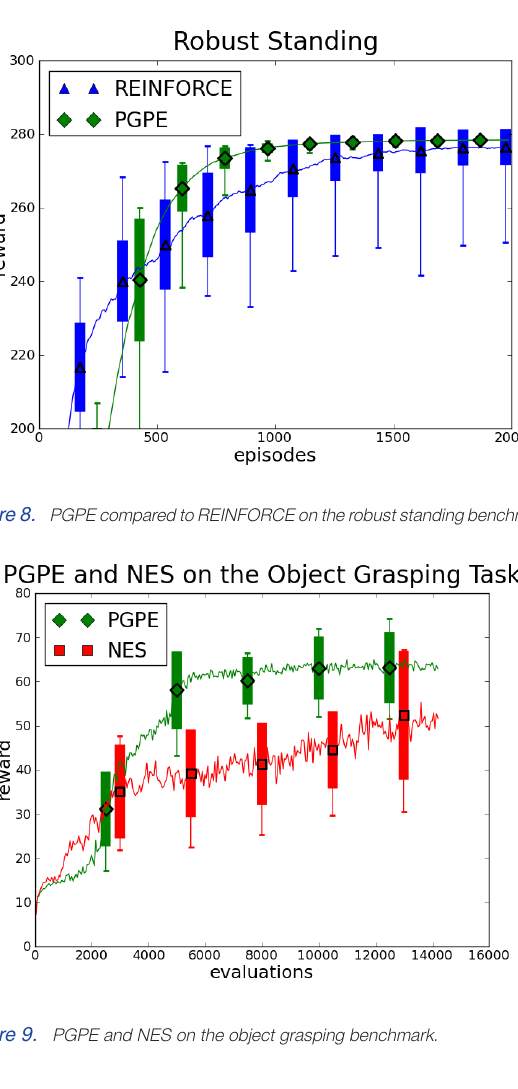
Figure 7. PGPE and NES compared to eNAC on the pole balancing bench- mark.